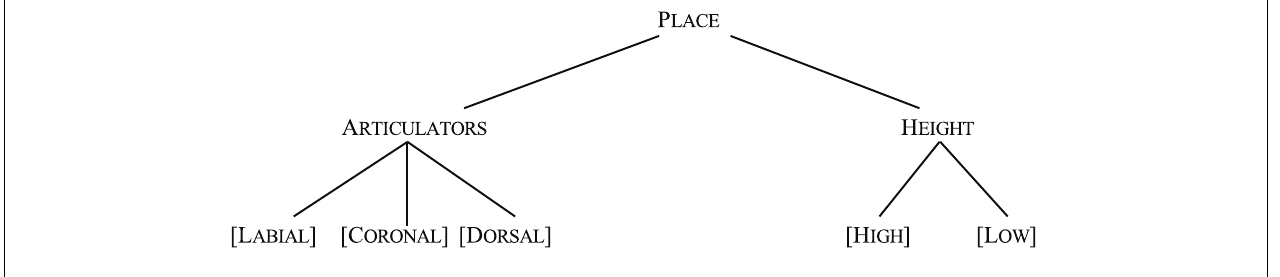
FIGURE 1 | Feature organization of PLACE OF ARTICULATION in FUL.